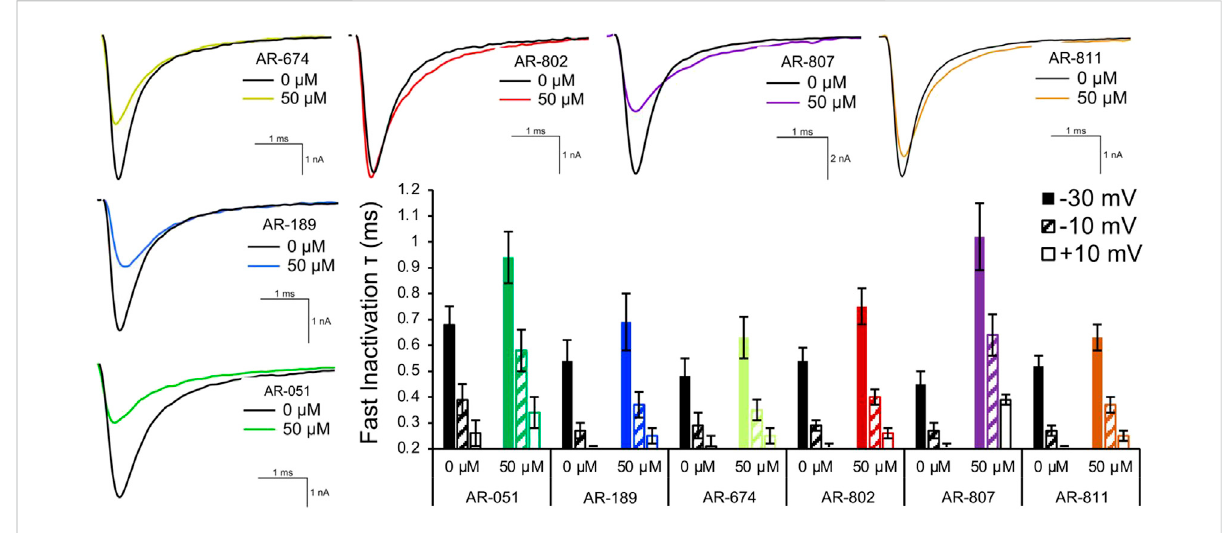
FIGURE 4 Fast inactivation onset. Representative traces are shown for vehicle (black) and compound treatment (varied colors) at – 20 mV. The bar graph displays the effects of the compound (50 μ M) on the fast inactivation time constant ( τ in milliseconds) at – 30 mV, – 10 mV, and +10 mV. Statistical signi fi cance is reported in Table